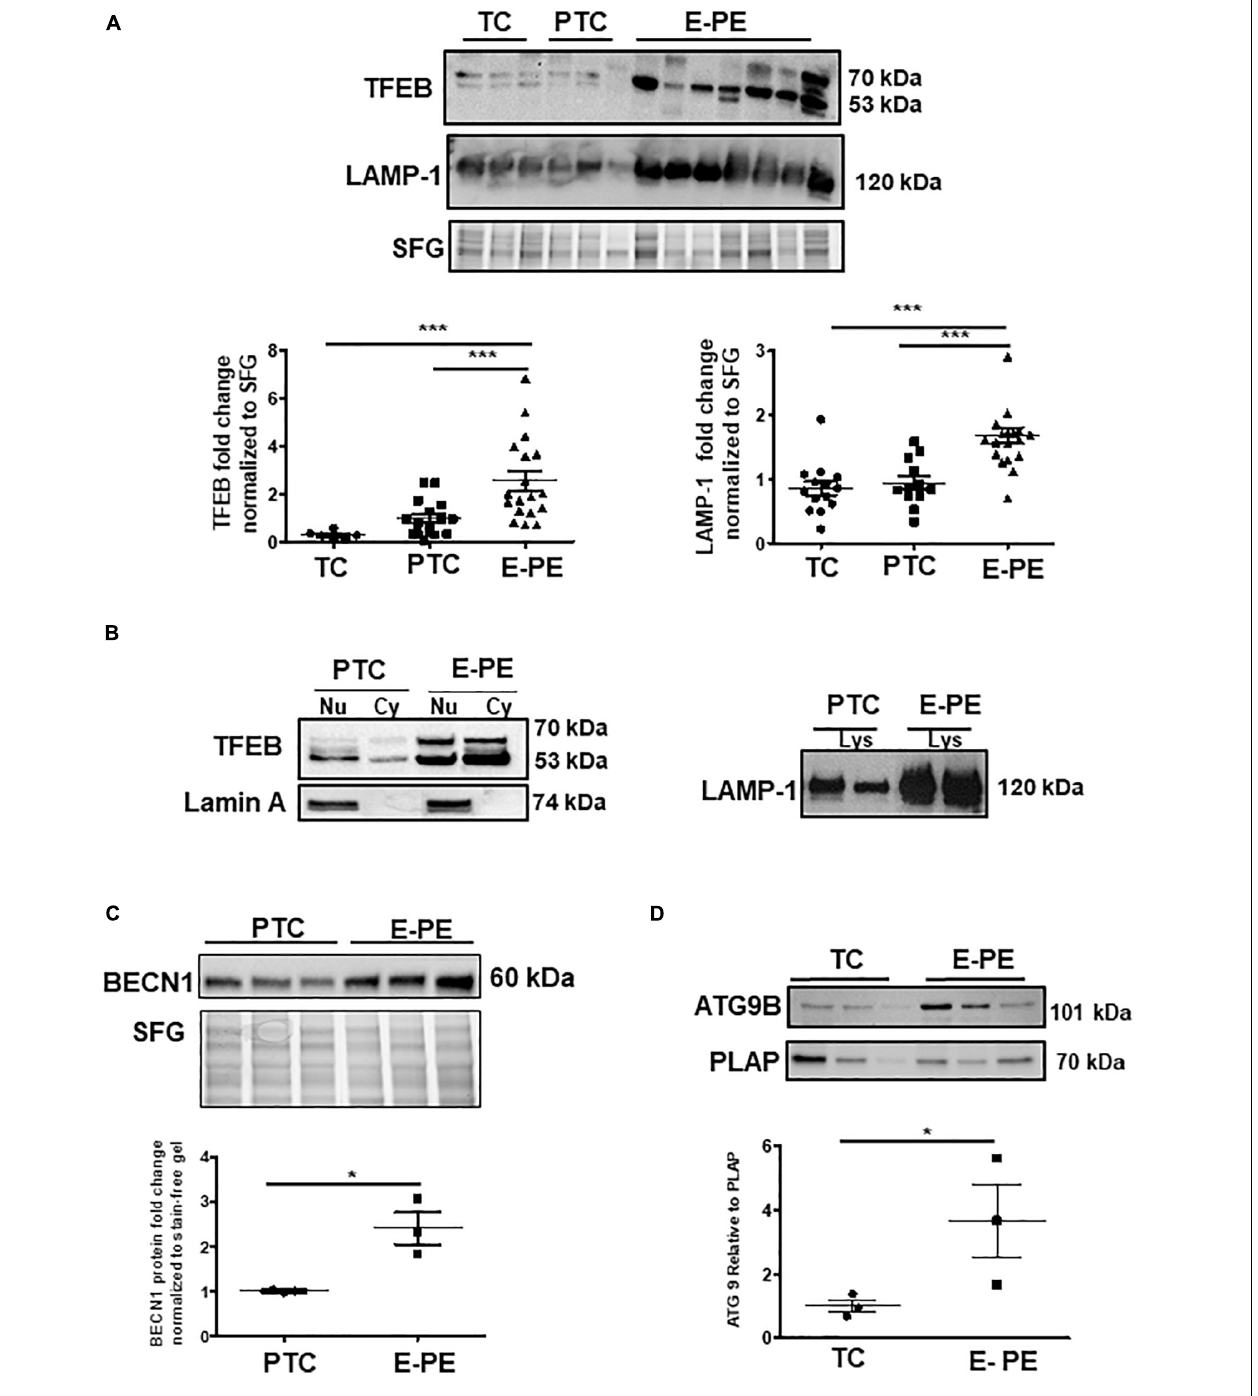
FIGURE 2 | Lysosome biogenesis is increased in E-PE placentae. (A) Representative WB and corresponding densitometry of TFEB and LAMP-1 in E-PE, PTC, and TC placentae normalized to total protein in stain free gel (SFG) (TFEB: E-PE N = 18, PTC N = 16, TC N = 6, *** P < 0.001 E-PE compared to PTC and TC); LAMP-1: E-PE N = 19, PTC N = 12, TC N = 14, *** P < 0.001 E-PE compared to PTC and TC). ( B, left panel ) WB for TFEB and Lamin A in nuclear (Nu) and cytoplasm (Cy) enriched fractions; ( B, right panel ) WB for LAMP1 in lysosomal lysates from PTC and E-PE placentae. (C) WB of Beclin-1 (BECN1) in PTC and E-PE placentae (PE, N = 7; PTC, N = 7). (D) Representative WB for ATG9b and corresponding densitometry in lysates of syncytial cells isolated from term and PE placentae. PLAP was used as a syncytial marker and loading control. (PE, N = 3; TC, N = 3; * P < 0.05 compared to TC). Dotted line: lanes were run on the same gel but were non-contiguous. Data are expressed as mean ±